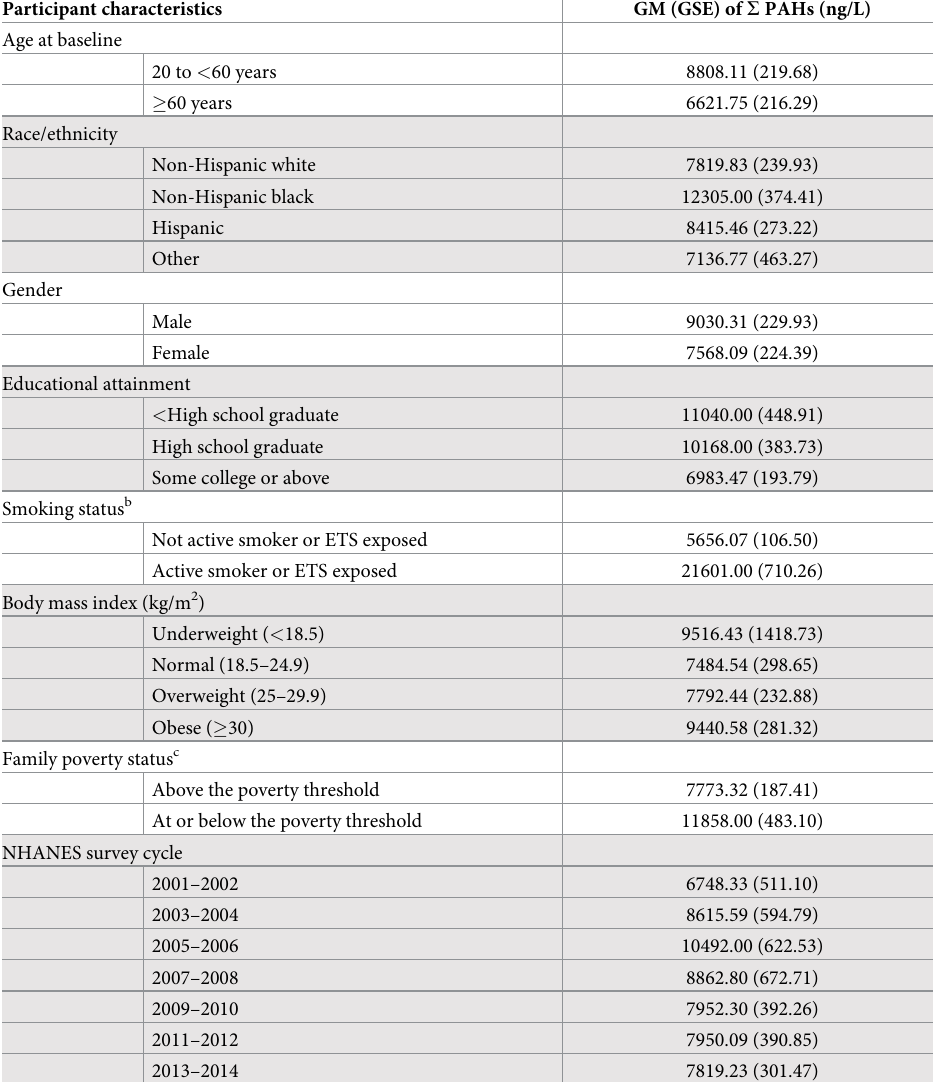
Table 2. Baseline S OH-PAHs (ng/L) a by participant characteristics (N = 9,739). Participant